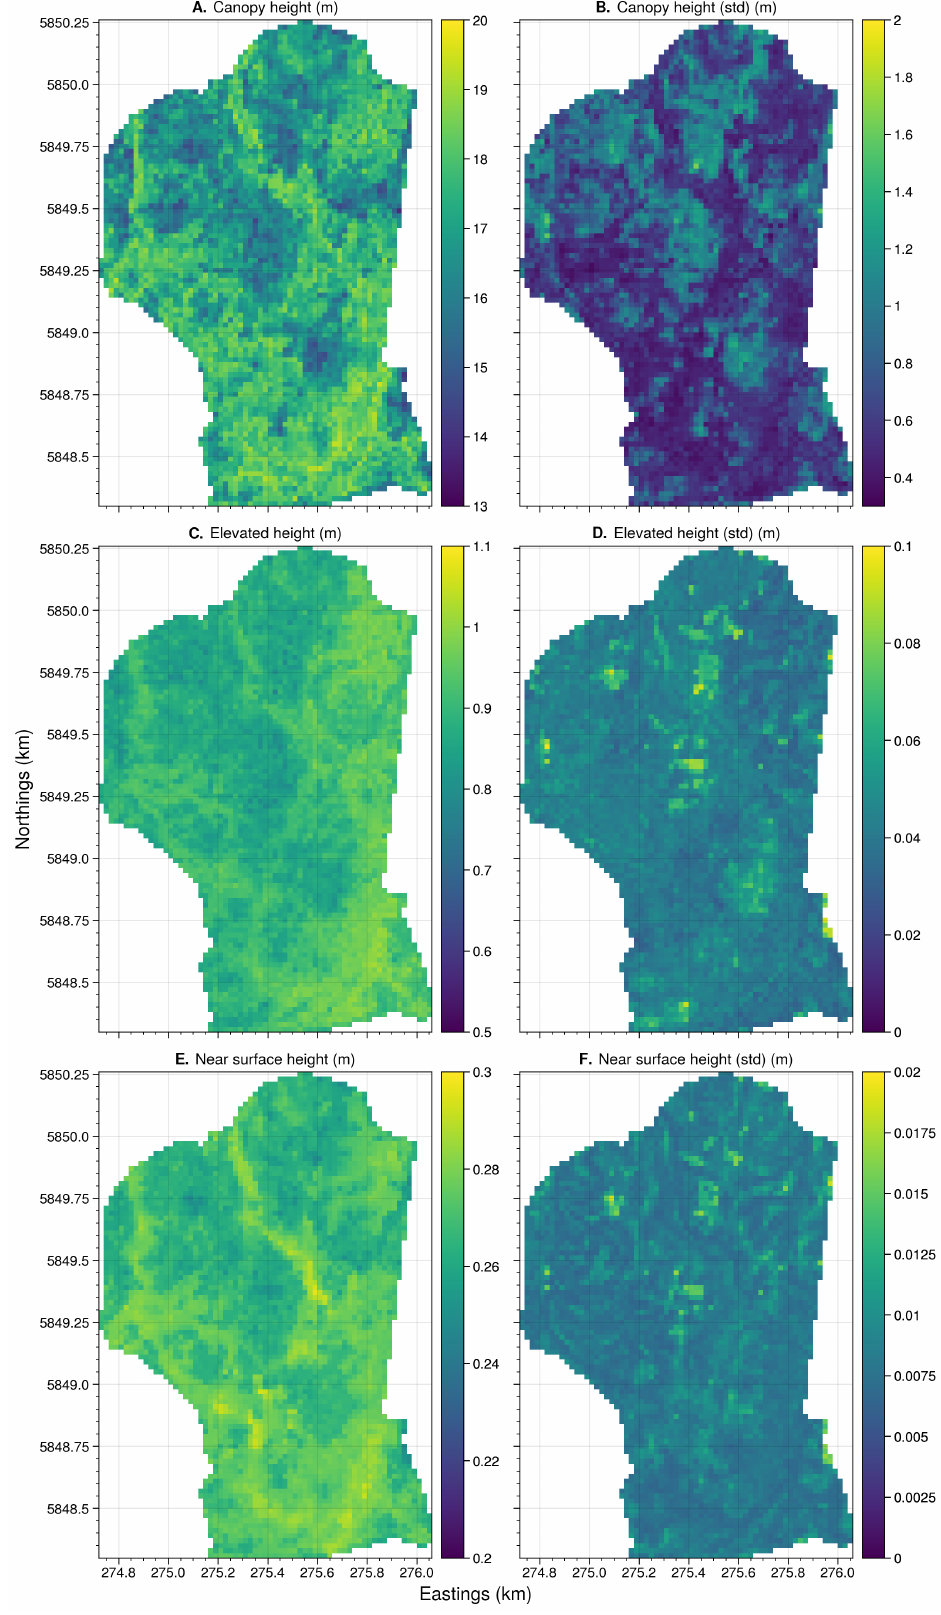
Figure A6. The mean and standard deviation predictions at landscape level for canopy ( A , B ), elevated ( C , D ), and near-surface ( E , F ) fuel height using TLS observations at